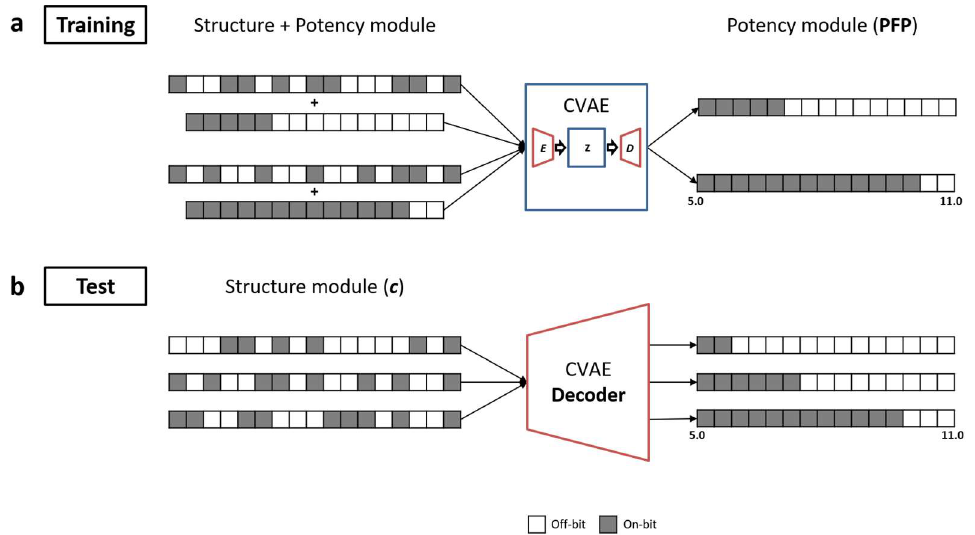
Figure 4. Conditional variational autoencoder modeling. In ( a , b ), the CVAE training and prediction strategies are illustrated, as discussed in the